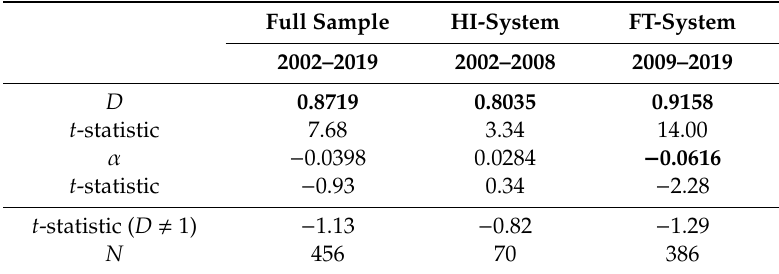
Table A1. Price-drop ratio on the ex-date (expected return adjustment).